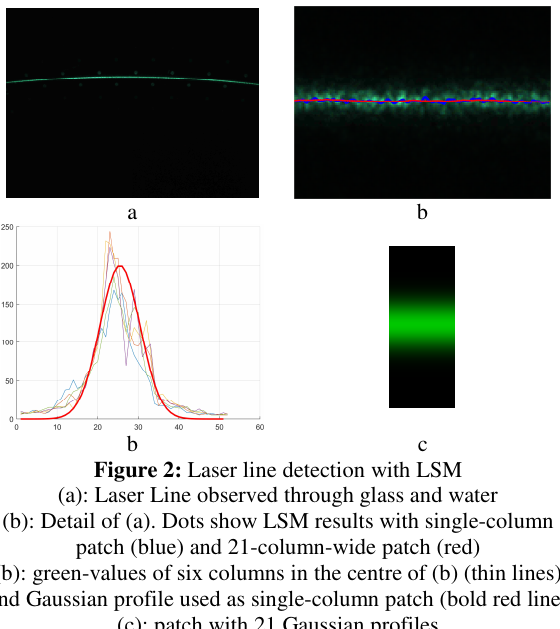
Figure 2: Laser line detection with LSM (a): Laser Line observed through glass and water (b): Detail of (a). Dots show LSM results with single-column patch (blue) and 21-column-wide patch (red) (b): green-values of six columns in the centre of (b) (thin lines) and Gaussian profile used as single-column patch (bold red line) (c): patch with 21 Gaussian profiles